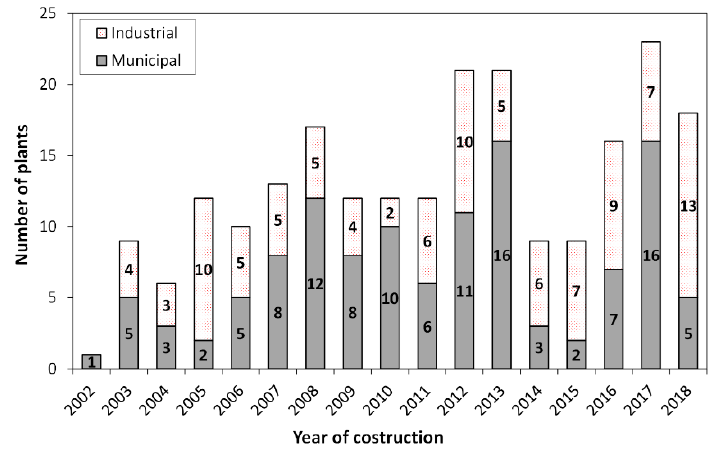
Figure 2. Number of MBR plants constructed in Italy